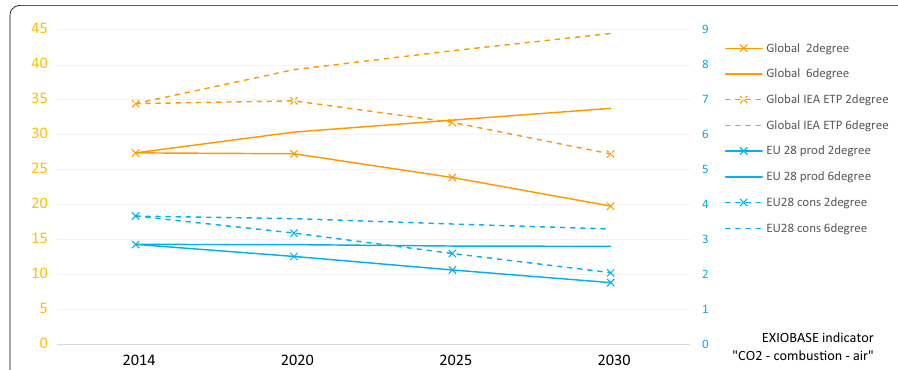
Fig. 2 Scenario results for EU’s production- and consumption-based CO 2 emissions in Gt CO 2